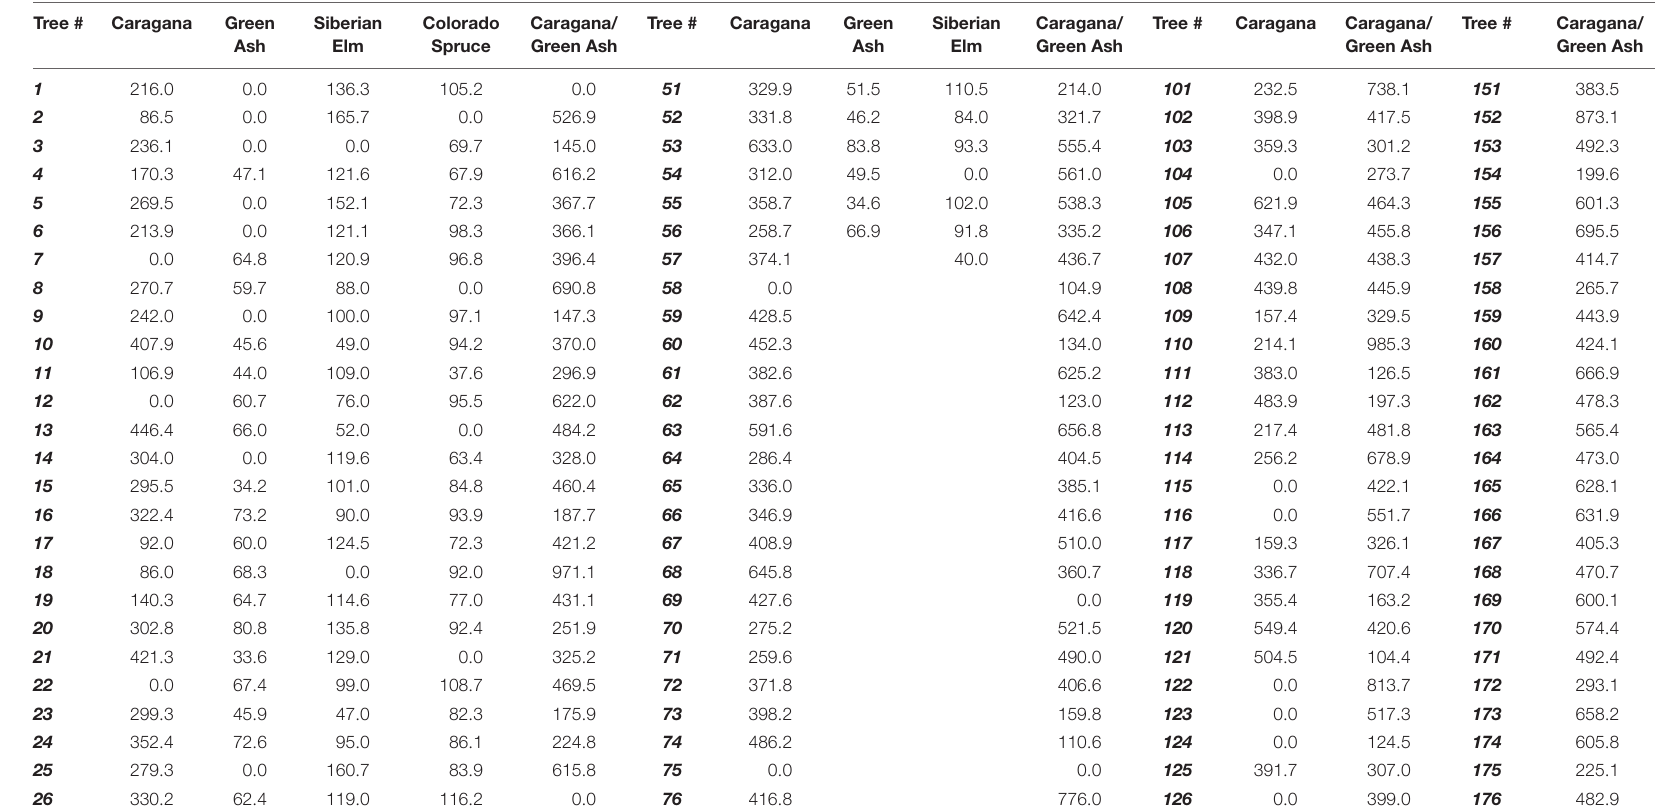
TABLE 2 | Calculated circumference on the basis of cumulative basal area (mm), using measurements from different shelterbelts near Indian Head, SK, Canada. Tree